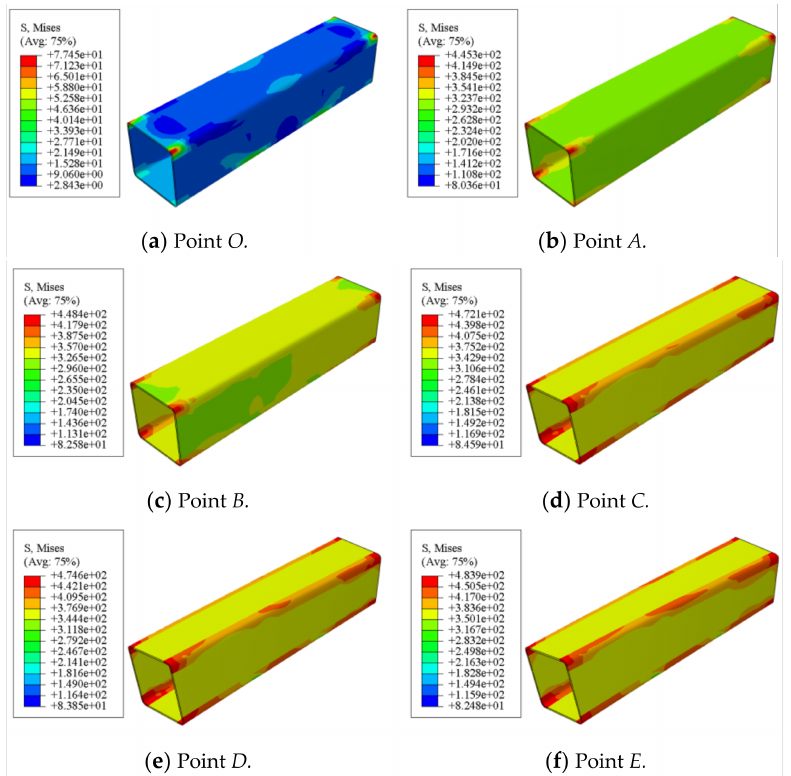
Figure 17. Mises stress distribution of